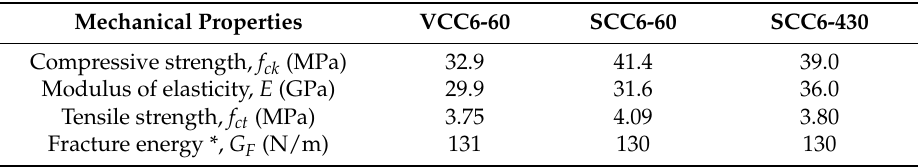
Table 2. Mechanical properties of the concrete